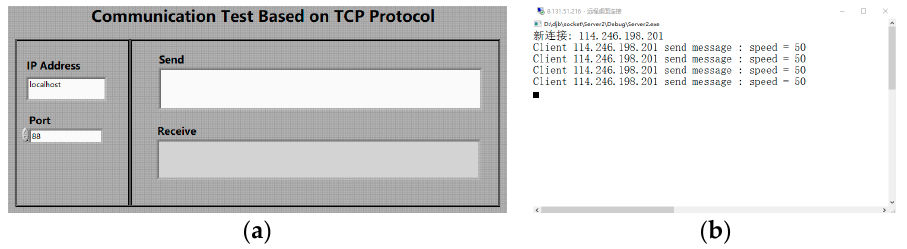
Figure 10. Data transfer test: ( a ) Client: interface for sending data from the upper computer. ( b ) Server: receiving real-time data.